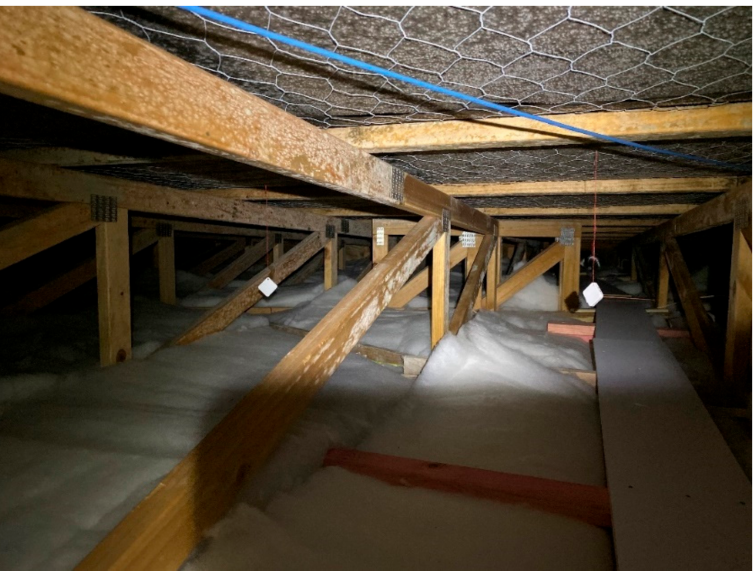
Figure 3. Roof space of the case study residential dwelling. Extensive mould growth is visible on the roofing underlay and the timber structure. Two hygrothermal sensors have been mounted in mid-air. Figure 4 shows the recorded air temperatures in the dwelling during the 2019/20 southern hemisphere summer period. The temperatures in the roof cavity, the living room and the outside are given. The vertical dashed line on 24/01 marks the installation of the solar-powered fan to the roof cavity. As an extract fan, it operates during daytime only with its efficiency coupled to the solar irradiance.